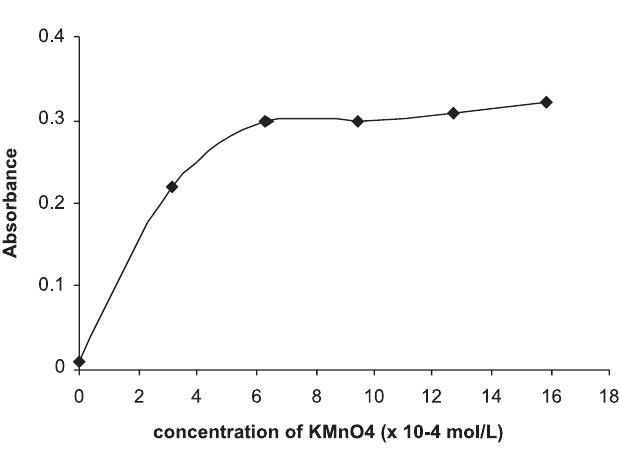
FIGURE 8 - Effect of KMnO